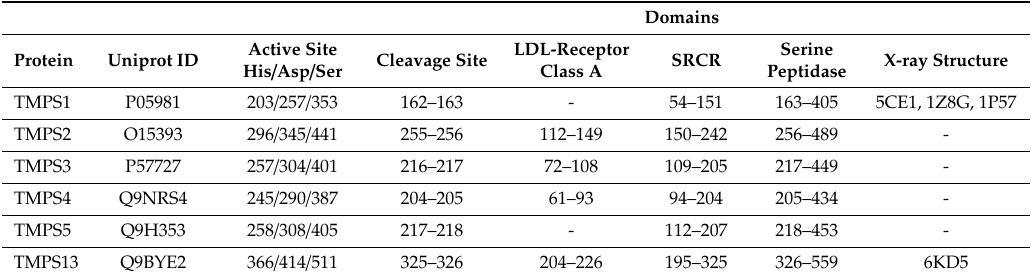
Table 3. Active site and domains of the most homologous TMPS proteins.